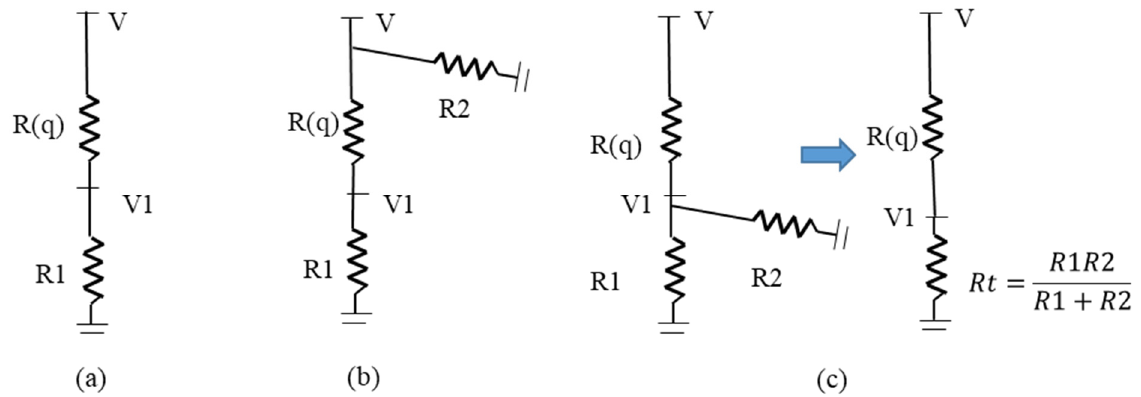
Figure 5. Simplified electrical circuit representation of the idealized models: ( a ) model 1: without side branch; ( b ) model 2: with side branch before the stenosis; ( c ) model 3: with side branch after the stenosis.